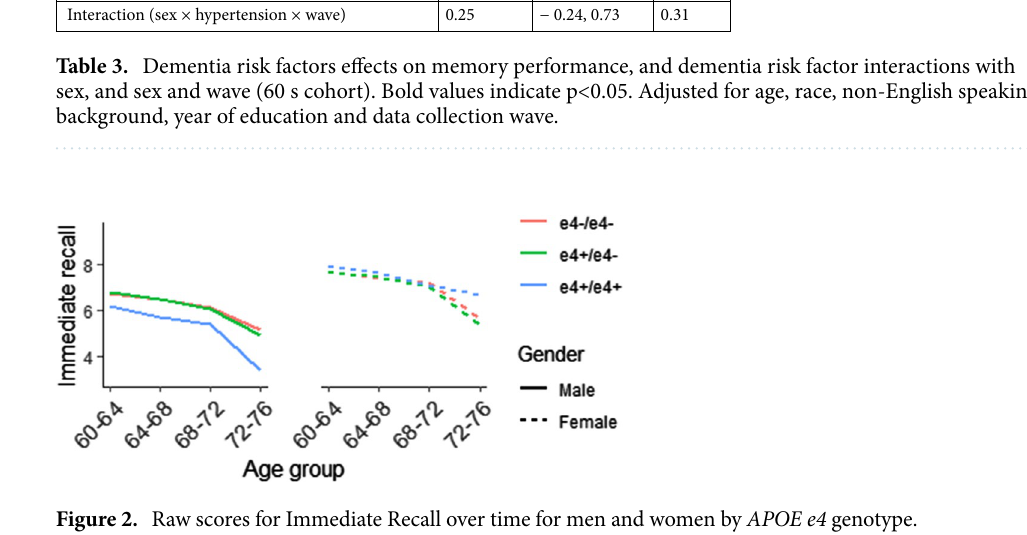
Figure 2. Raw scores for Immediate Recall over time for men and women by APOE e4